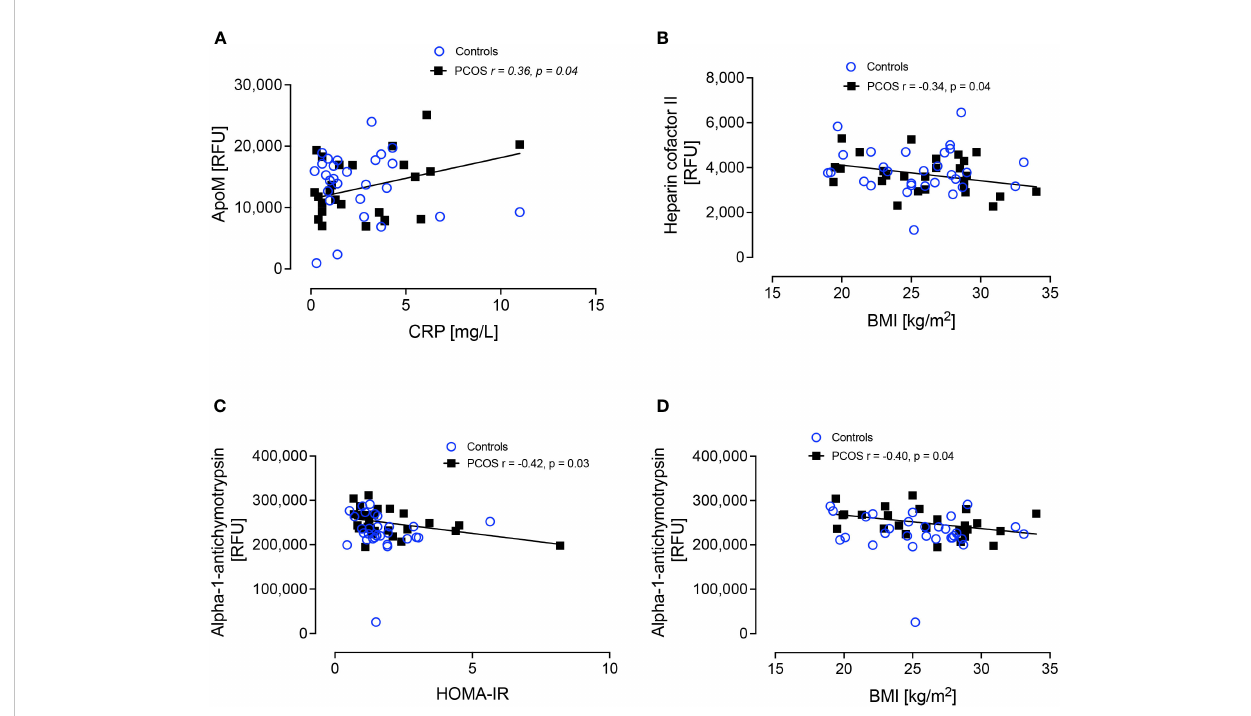
FIGURE 4 Correlations of ApoM and CRP (A) , Heparin cofactor II and BMI (B) , alpha-1-antichymotrypsin and HOMA-IR (C) and alpha-1-antichymotrypsin and BMI (D)